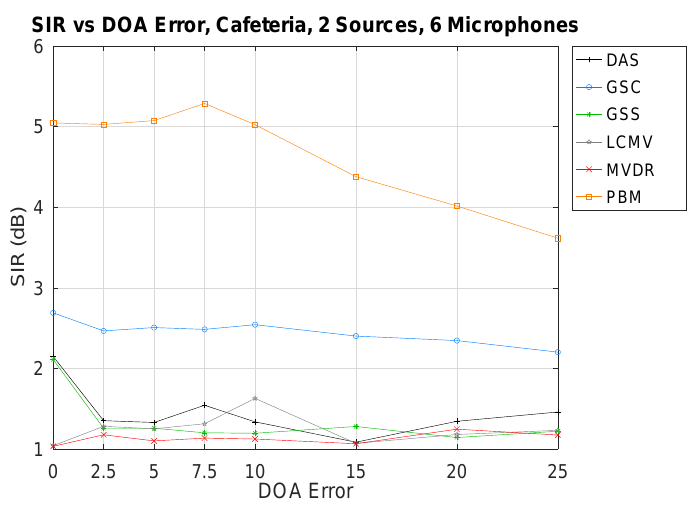
Figure 8. SIR vs. DOA error in the